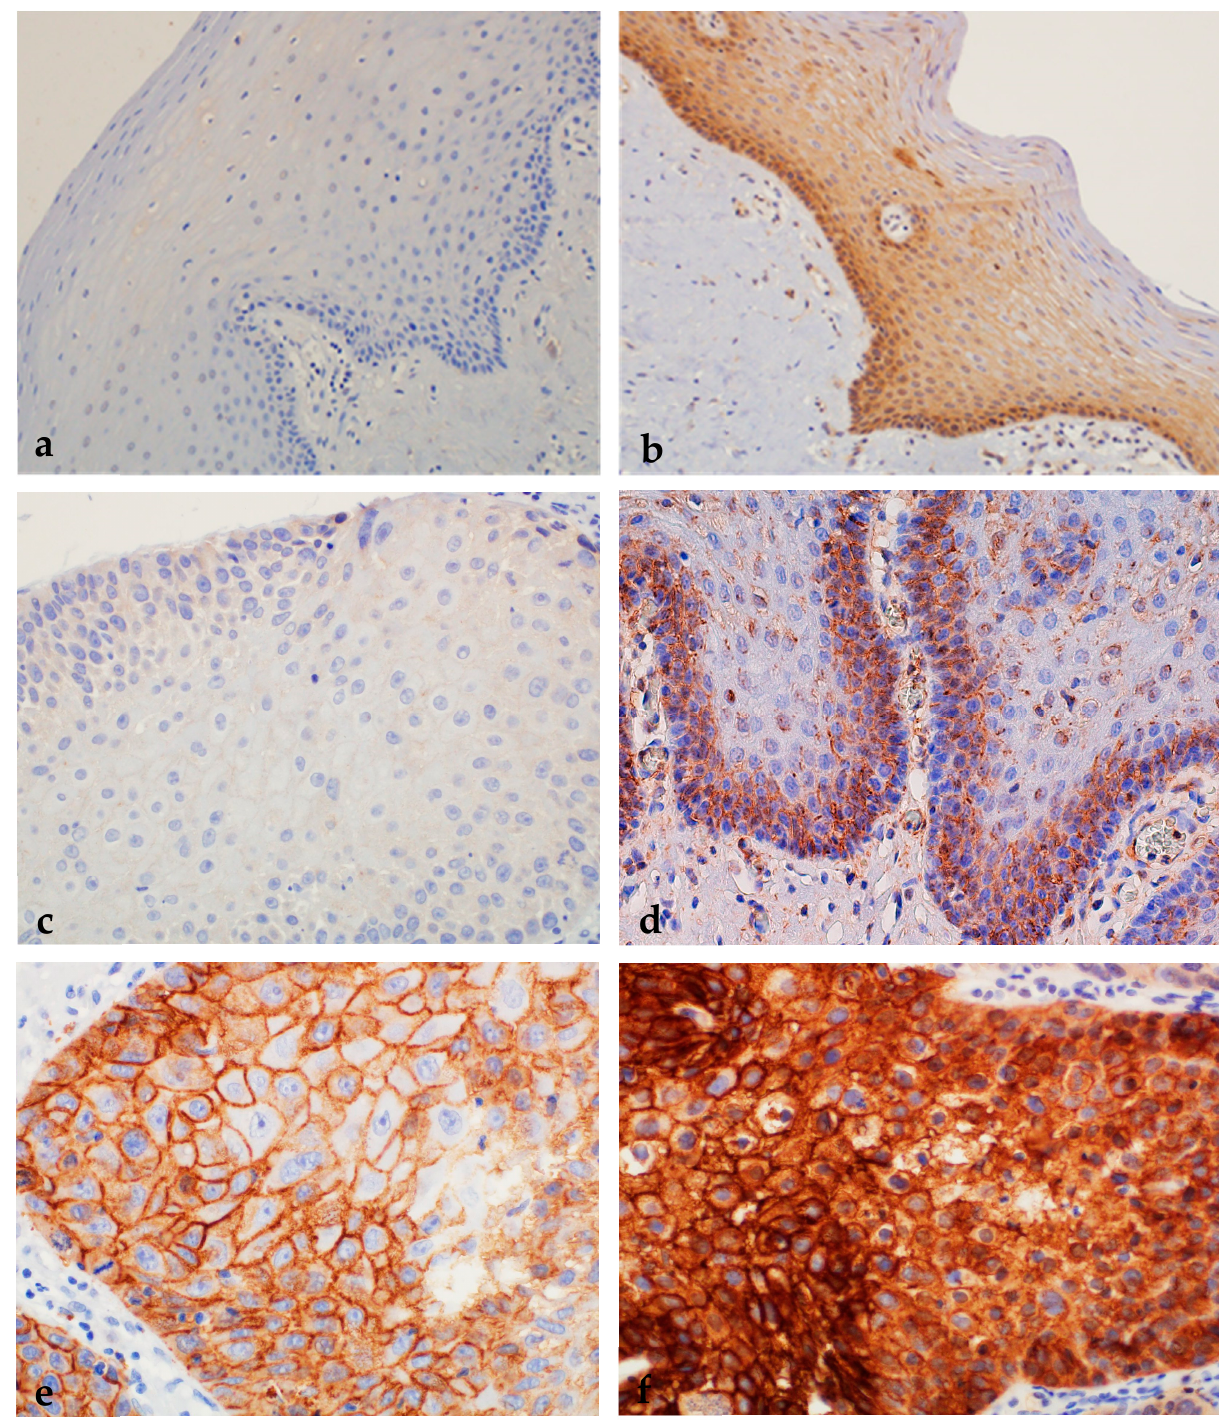
Figure 10. Immunohistochemical expression of mEGFR in healthy oral mucosa, oral premalignant changes, and OSCCs . ( a ) Negative expression of EGFR on the membrane of oral epithelium. ( b ) Moderate complete membrane staining of EGFR in oral mucosa (++). Magni fi cation 200×. ( c ) Incomplete membrane staining of EGFR in more than 10% of cells in oral leukoplakia (+). ( d ) Moderate complete membrane staining of EGFR in oral leukoplakia (++). Magni fi cation 400×. ( e ) Moderate complete membrane staining of EGFR in more than 10% of cells in OSCC (++). ( f ) Strong complete membrane staining in more than 10% of cells in OSCC (+++). Magni fi cation 400×.